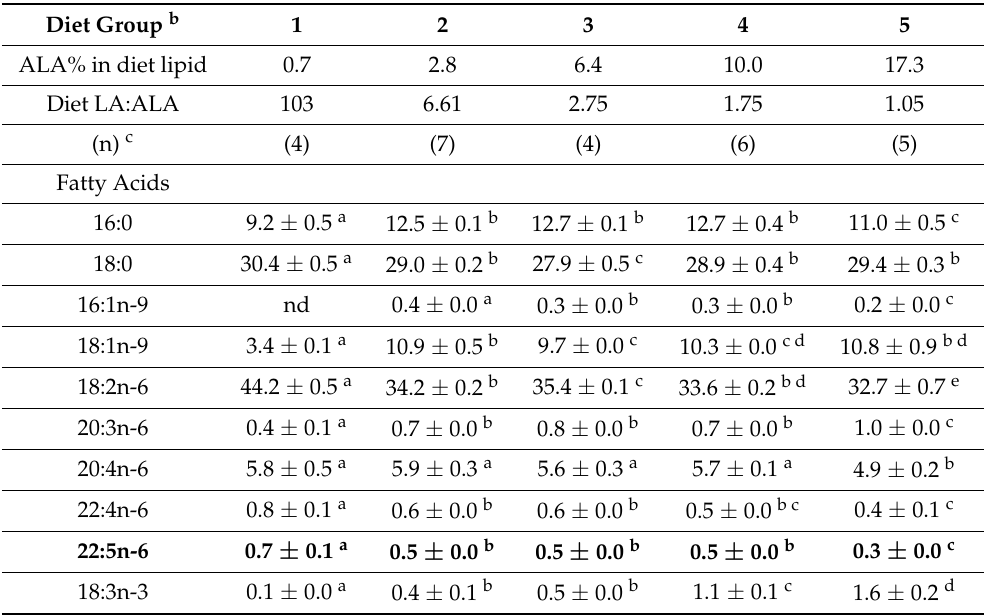
Table A3. Effect of increasing dietary ALA on liver fatty acid proportions (g/100 g phospholipid fatty acids) a